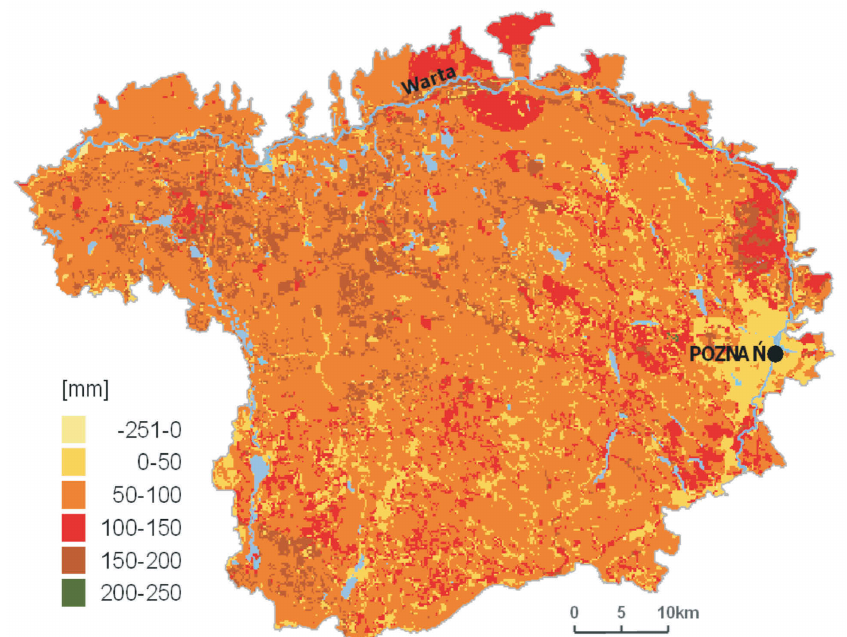
Fig. 3. Areal distribution of mean annual effective infiltration (1961–2000) in the Poznan Plateau region – WetSpass model result (1961–2000). The information values are matched with raster (balance) cells with the area of xy=0.0625 km